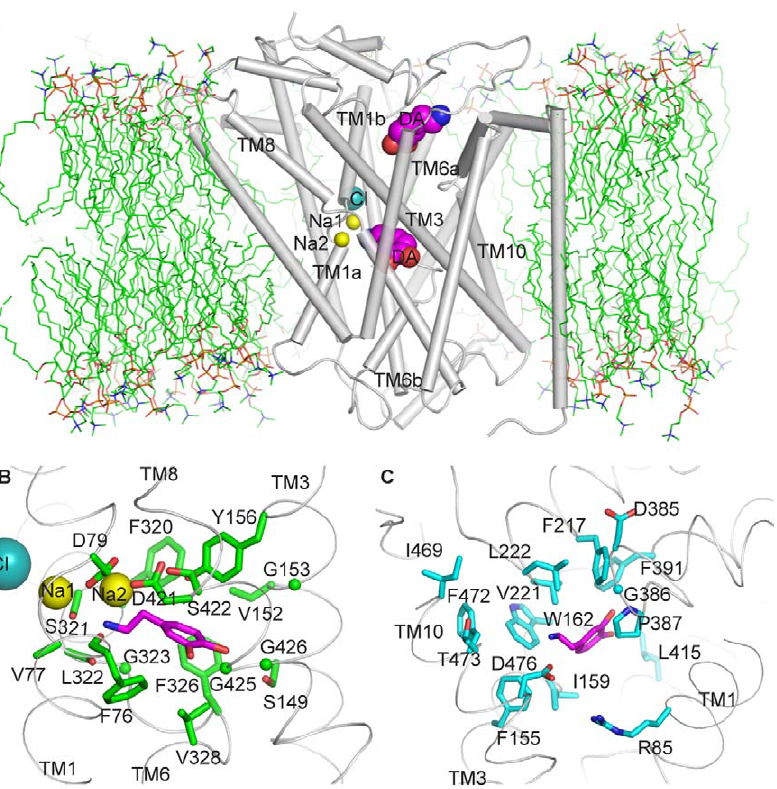
Figure 1. The substrate binding sites of DAT. ( A ) S1,S2-DAT with DA in both the S1 and S2 sites, immersed in a lipid bilayer. The S1 site is located in the middle of the TM bundle and the S2 site is located , 10 A˚ above the S1 site. ( B ) DA in the S1 site interacts with residues from TMs1, 3, 6 and 8 (viewing perspective is similar to that in ( A )). ( C ) DA in the S2 site interacts mainly with residues from TMs1, 3 and 10, EL2, and EL4 (viewed from the exit of the extracellular